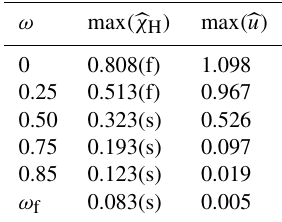
Table 2. Maximum scaled Hayhurst stress and velocity for water depth experiments. The s and f letters indicate whether the scaled Hayhurst stress maxima were found at the surface or at the bottom of the calving front, respectively.